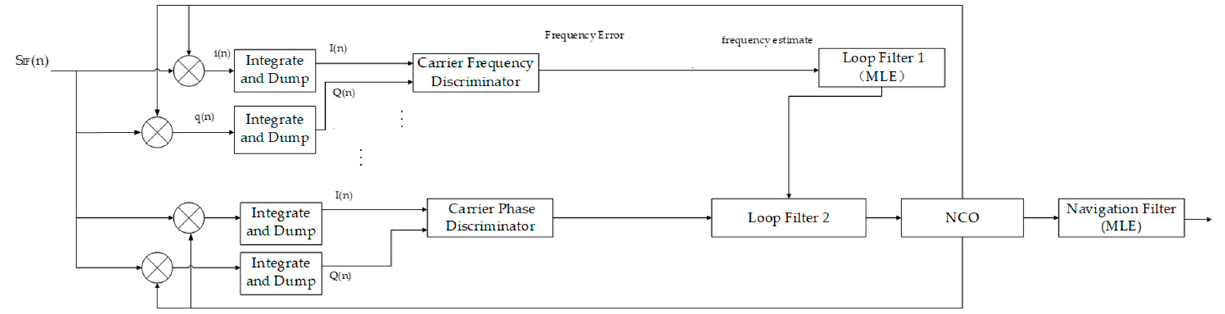
Figure 2. Block diagram of the FLL-assisted PLL structure.